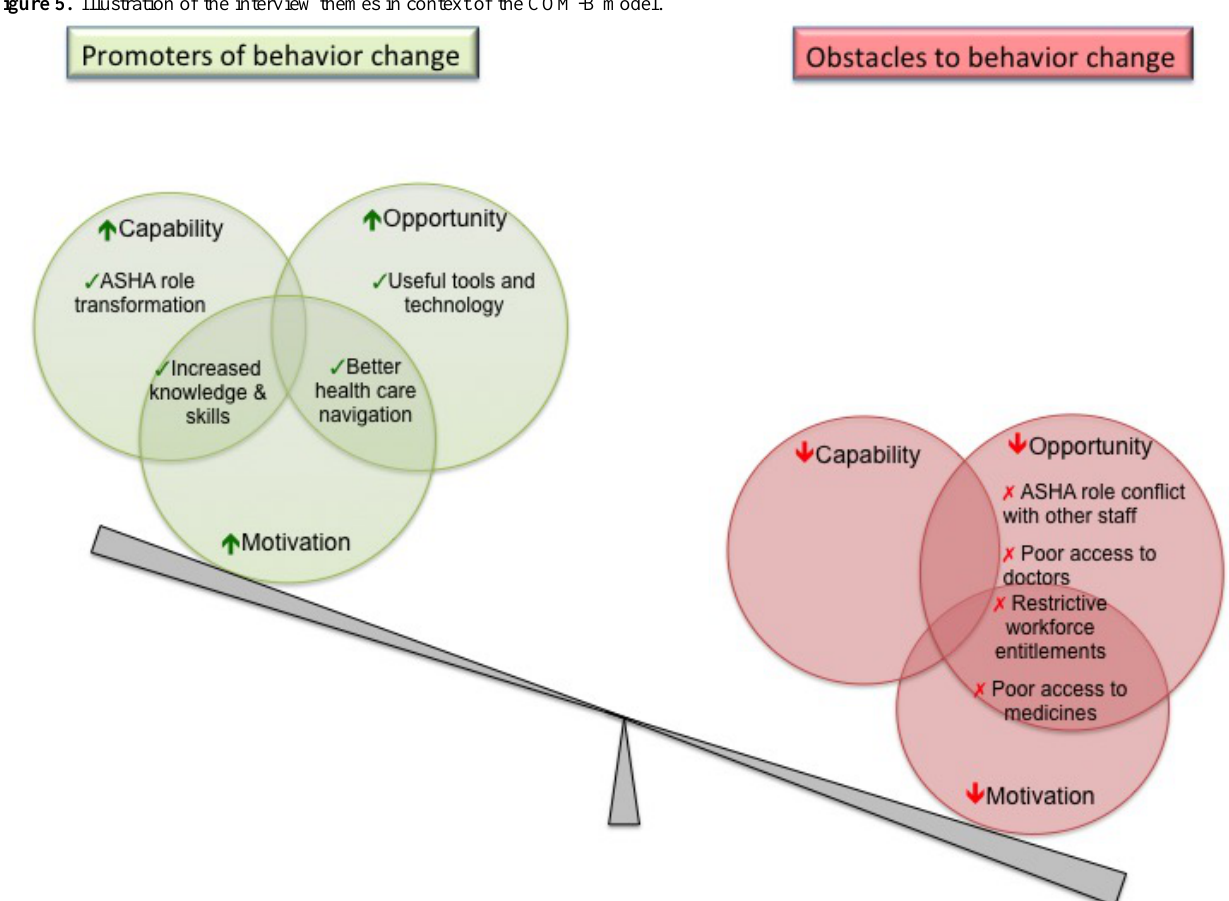
Figure 5. Illustration of the interview themes in context of the COM-B